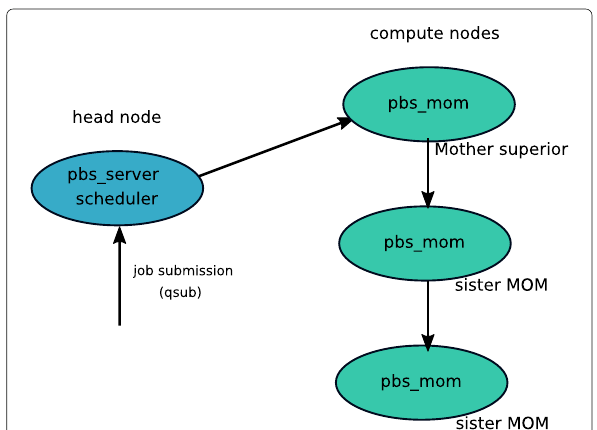
Fig. 1 TORQUE structure. pbs _ server , scheduler and pbs _ mom are the daemons running on the nodes. Mother Superior is the first node on the node list that finds by the scheduler